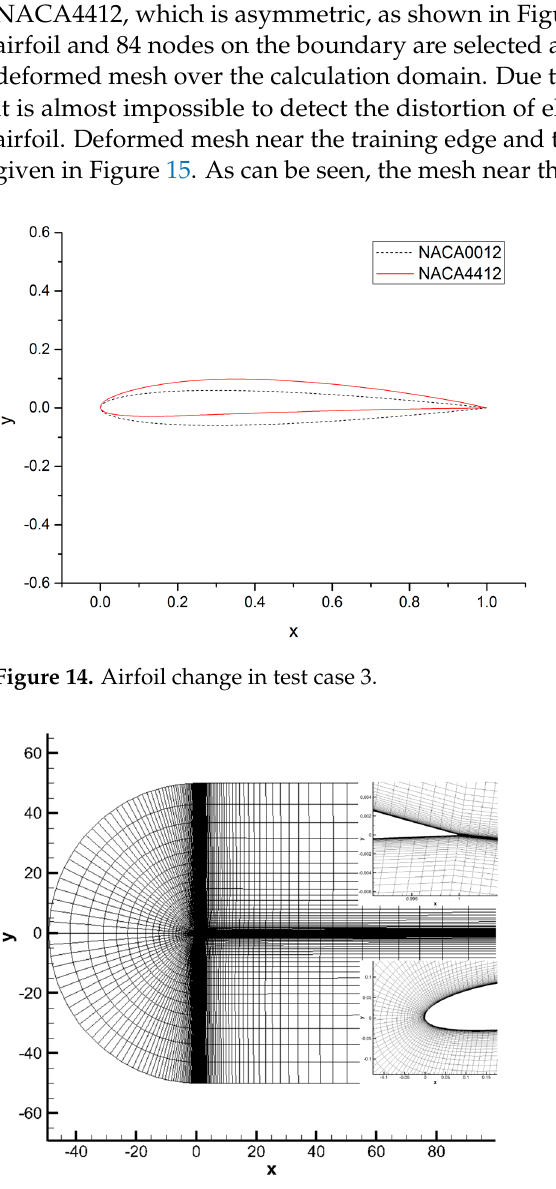
Figure 15. Deformed mesh in test case 3.